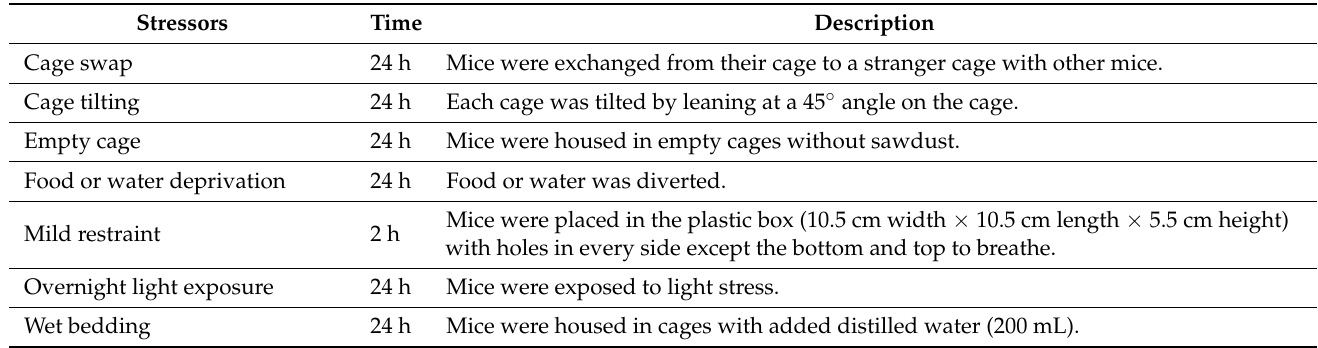
Table 1. Chronic unpredictable mild stress (CUMS)